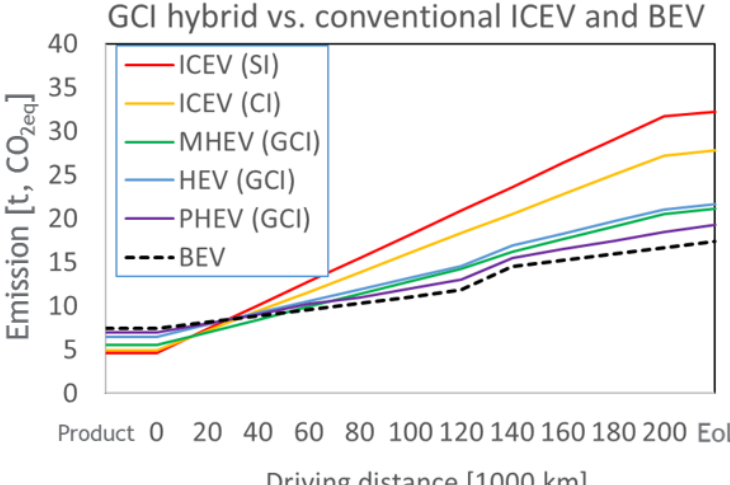
Figure 12. Accumulated GHG emissions during the vehicle lifetime for GCI hybrids versus conventional ICEV and BEF based on life cycle analysis (LCA), (EoL: end of life, WLTC).